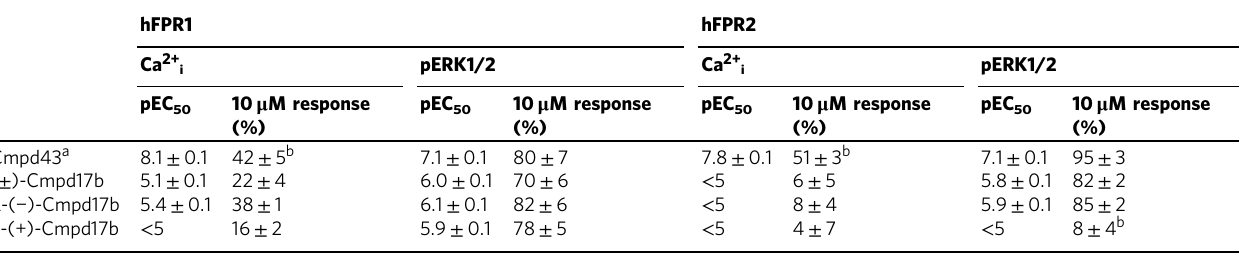
Data represents the mean ± S.E.M. of 3 – 7 separate experiments, each conducted in duplicate or triplicate a Values determined from previously published data 6 b Signi fi cantly different, P < 0.05 compared to the corresponding 10 μ M response (% positive control) value for ( ± )-Cmpd17b, one-way ANOVA with Dunnett ’ s post hoc